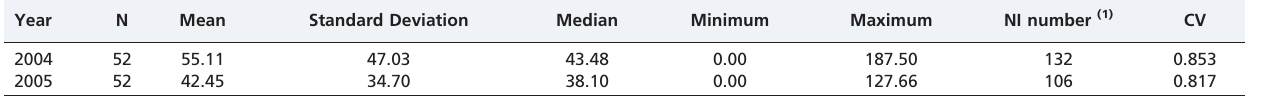
Table 2 - The incidence density rate per 1,000 patients per day in the adult ICU for 2004 and